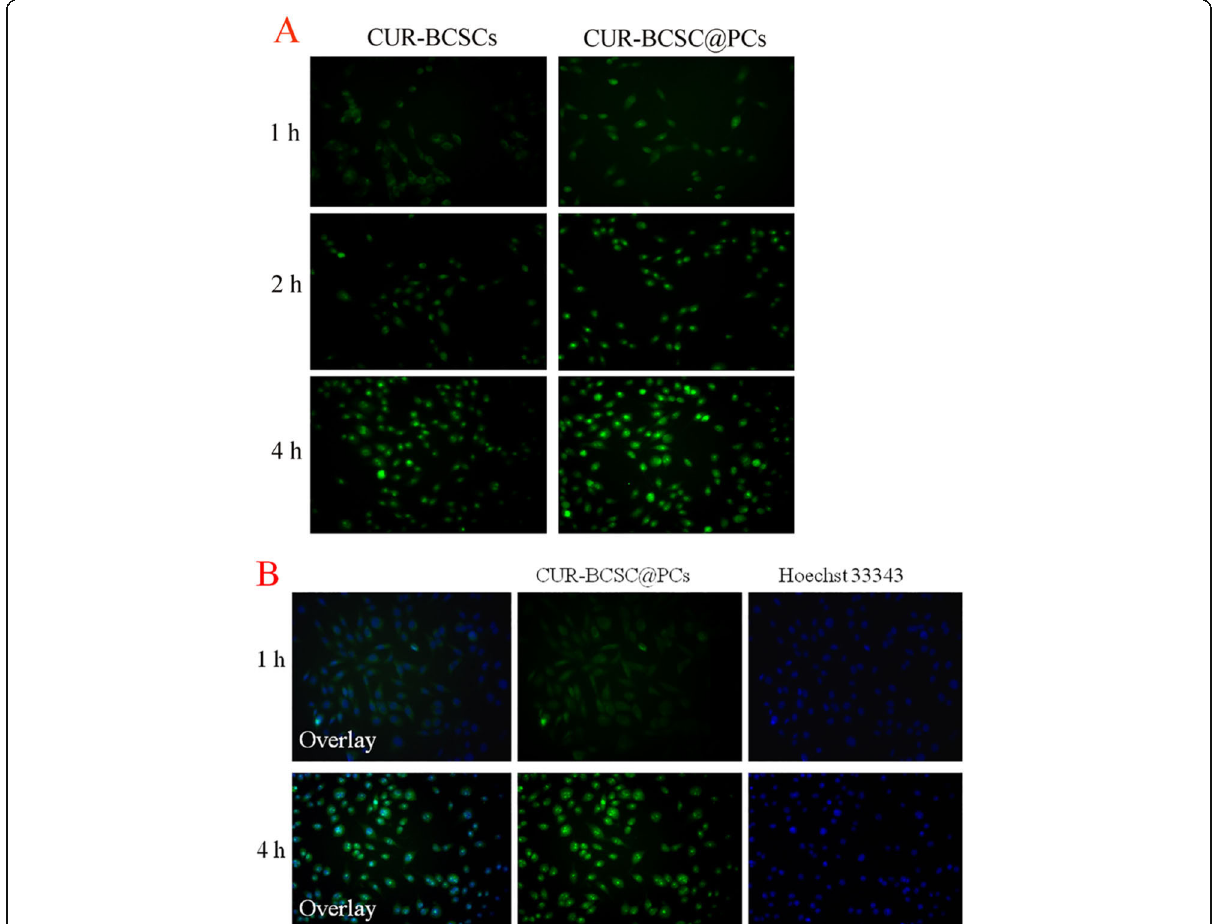
Fig. 9 a Fluorescent imaging of the cellular uptake of CUR-BCSCs and CUR-BCSC@PCs at different times. b The cell location of CUR-BCSC@PCs at 1 h and